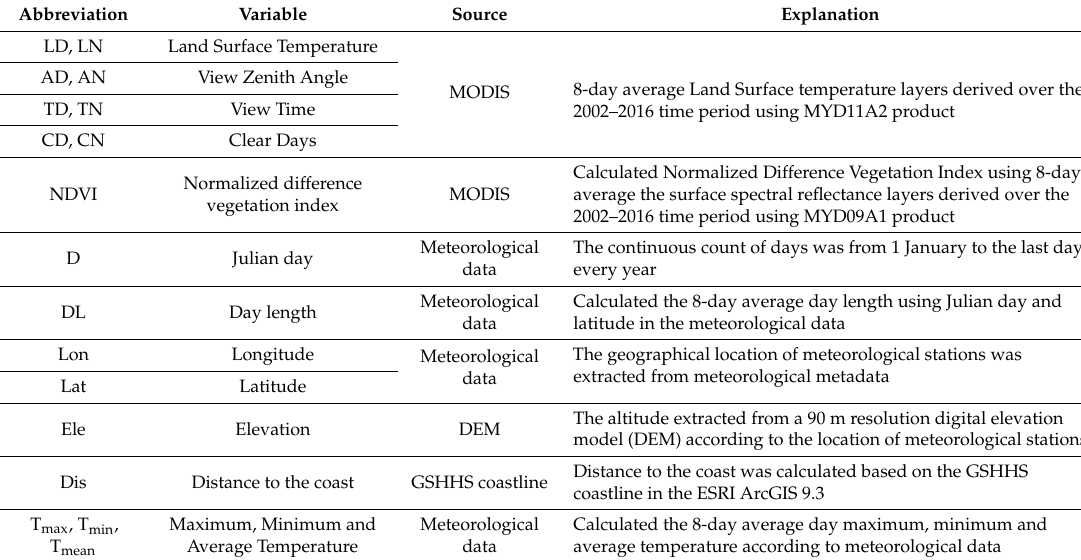
Table 1. Data sources and